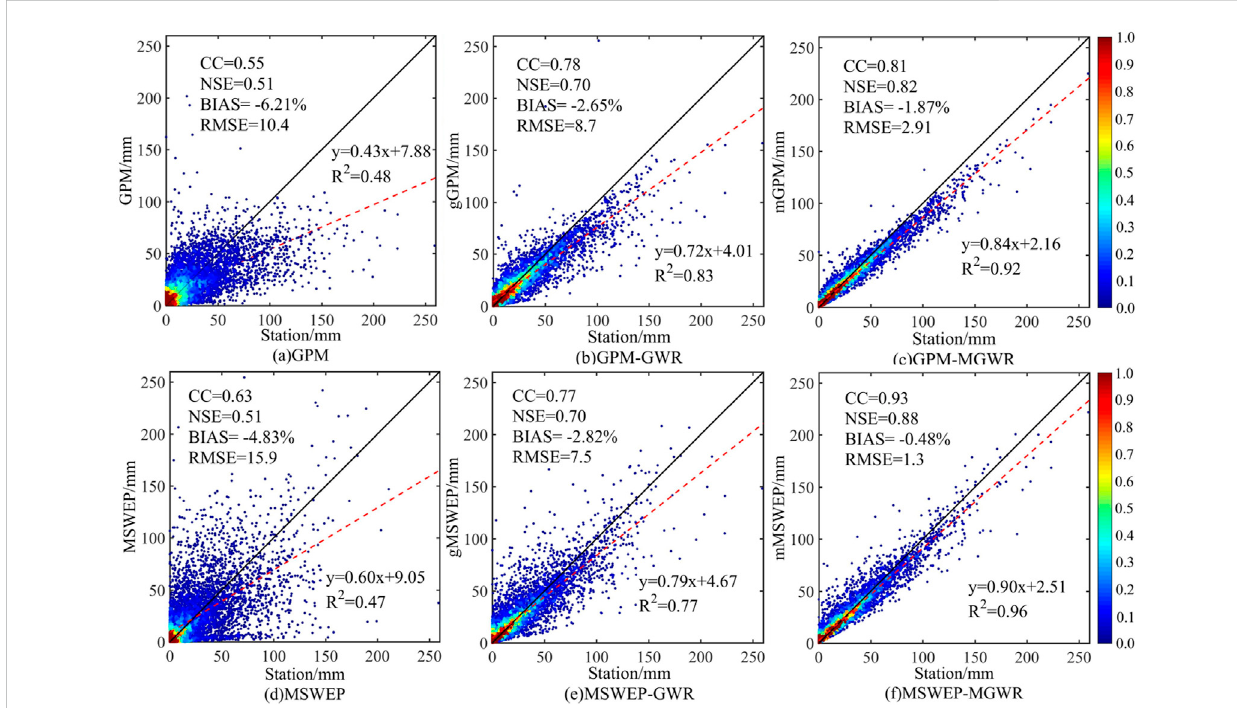
FIGURE 5 Scatter density of GPM and MSWEP and their downscaling results with measured monthly precipitation (A) GPM; (B) GPM-GWR; (C) GPM-MGWR; (D) MSWEP; (E) MSWEP-GWR; (F) MSWEP-MGWR.